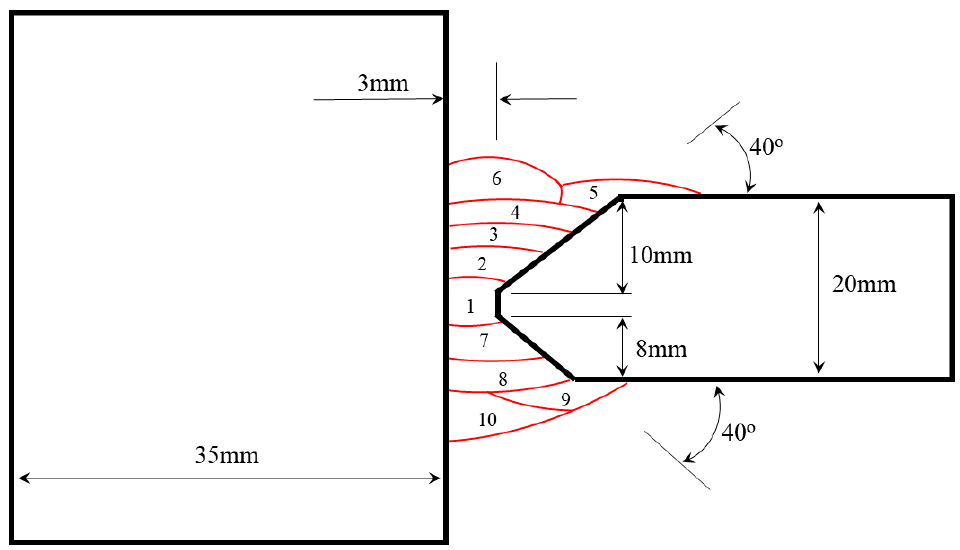
Figure 1 . Plate dimensions and weld